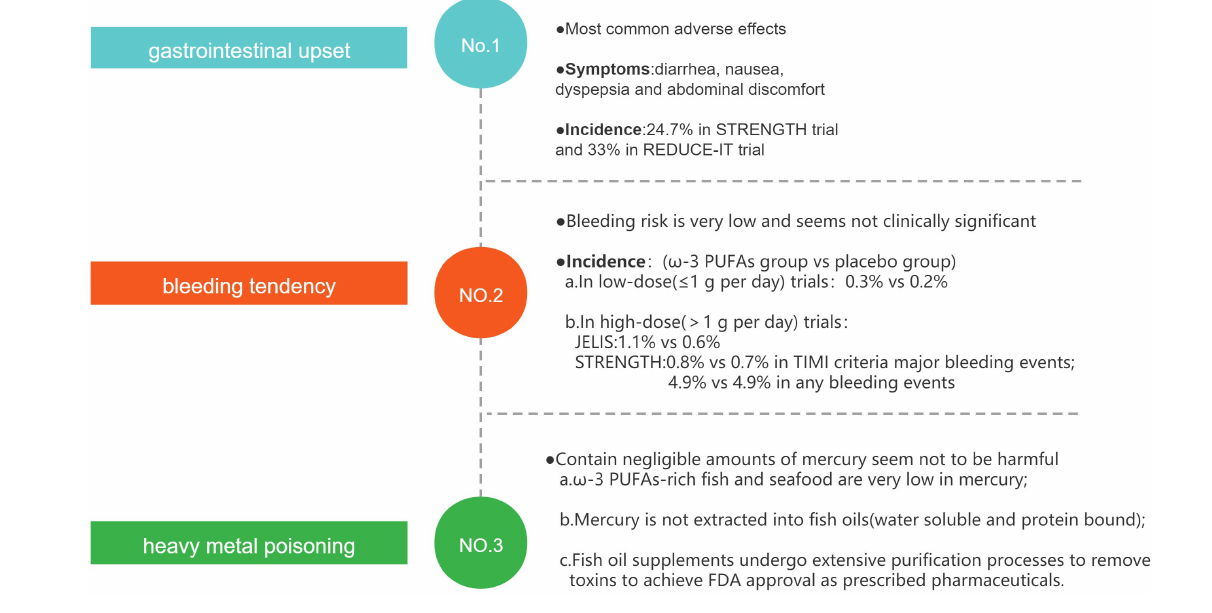
FIGURE 7 | The potential adverse effects of fish